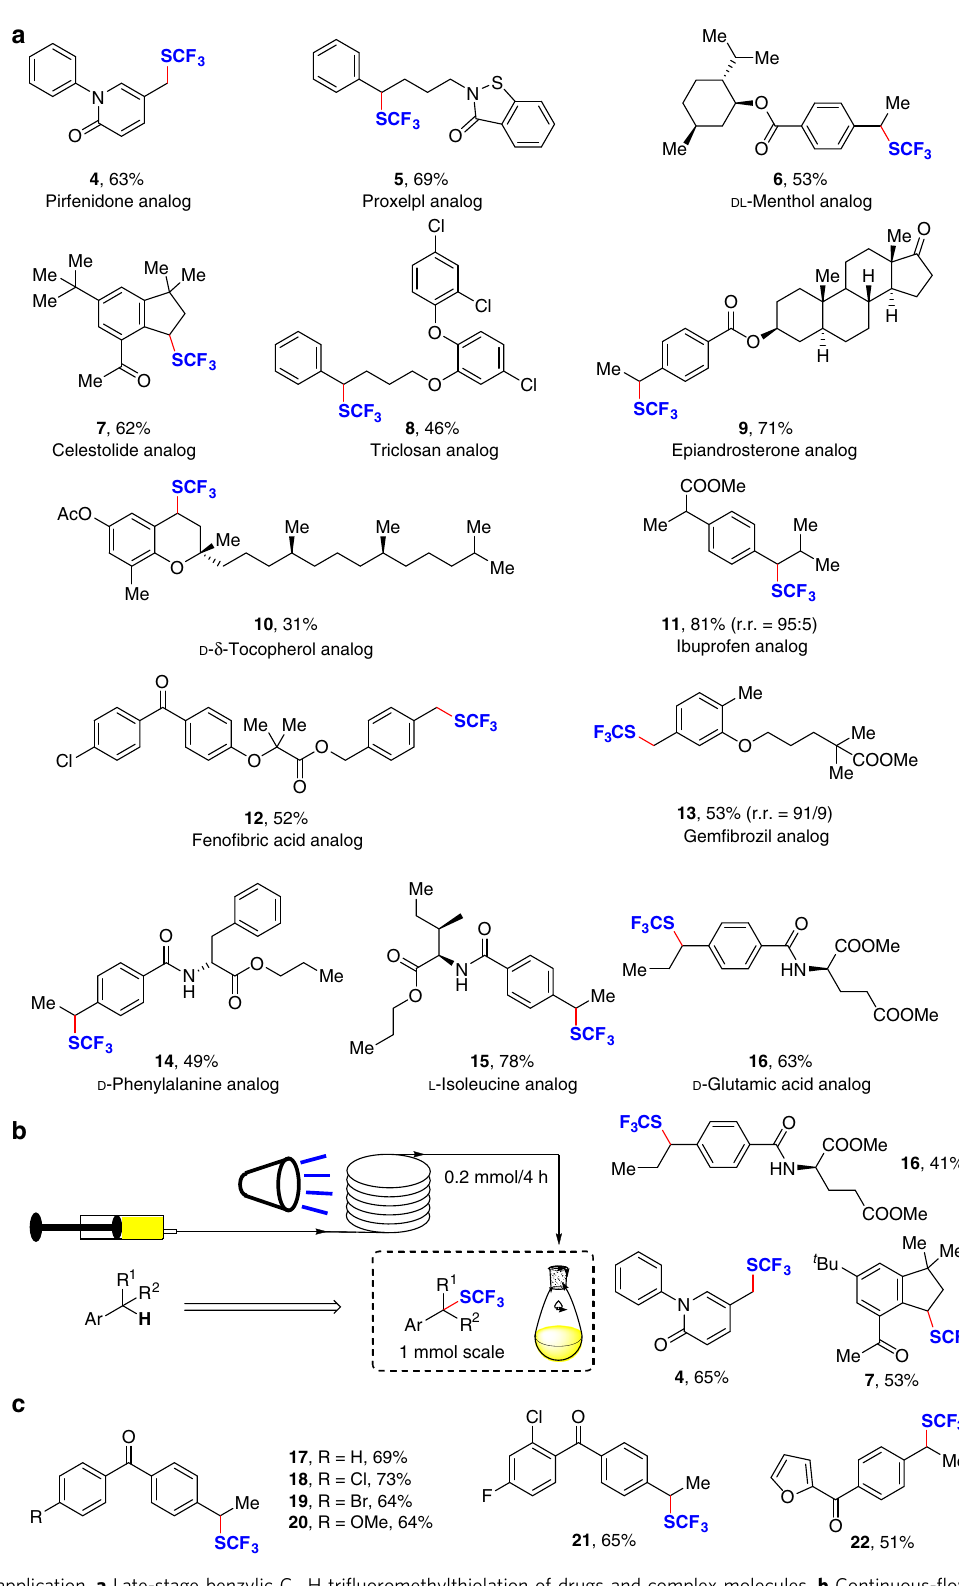
Fig. 3 Synthetic application. a Late-stage benzylic C − H tri fl uoromethylthiolation of drugs and complex molecules. b Continuous- fl ow